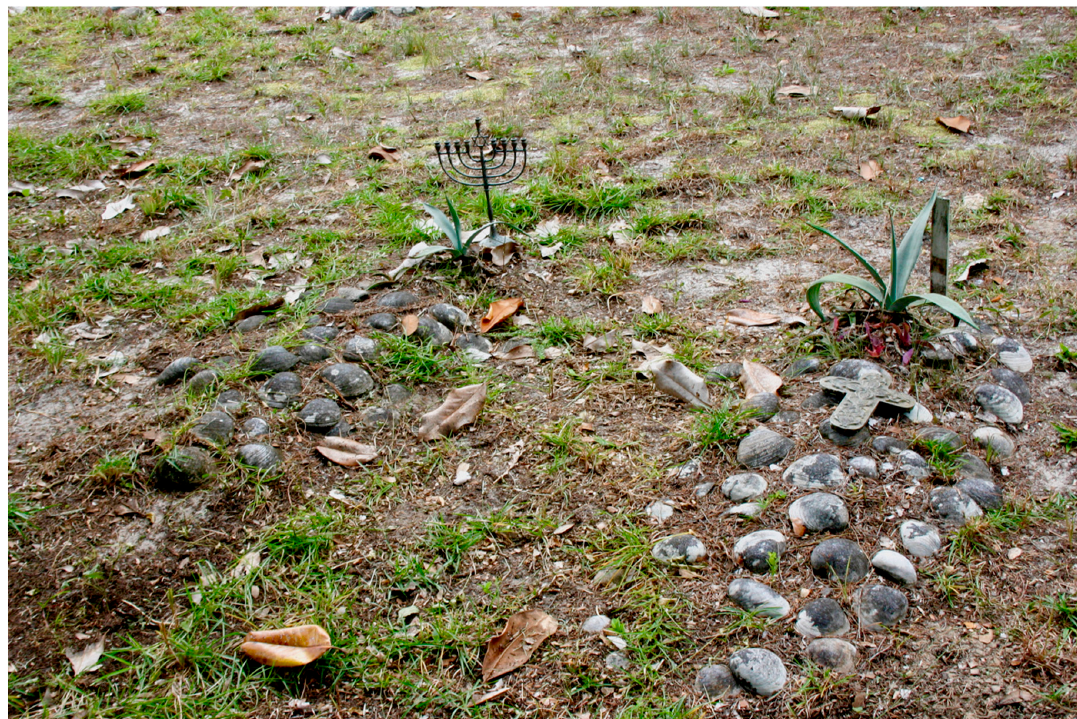
Figure 6. Two children’s graves arranged with discolored shell. The graves each have a plant at the head, along with a menorah and a cross, respectively. Photograph courtesy of the author.